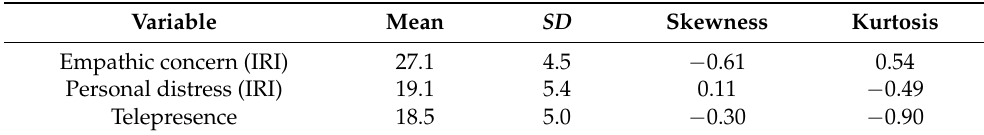
Table 1. Descriptive statistics of the psychological variables. The telepresence measure refers to the experimental experience.